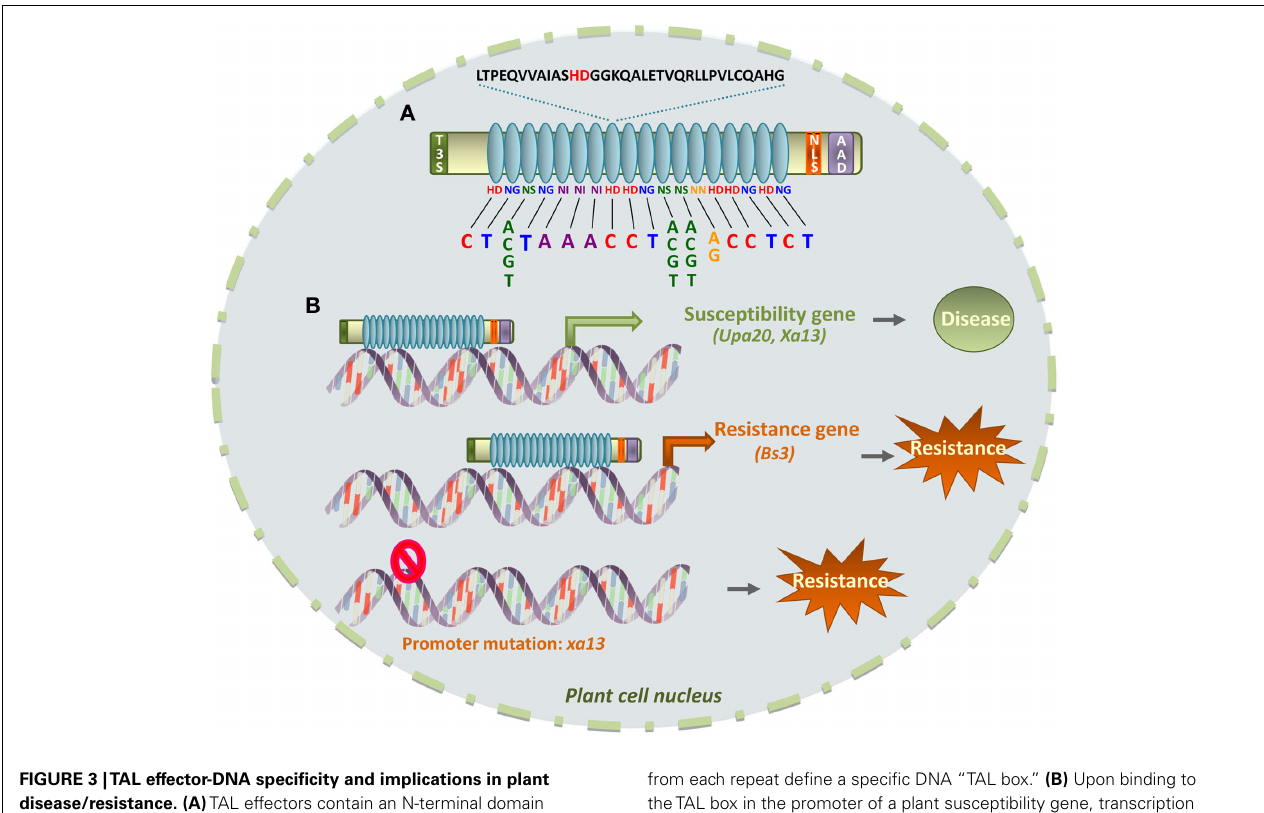
FIGURE 3 |TAL effector-DNA specificity and implications in plant disease/resistance. (A) TAL effectors contain an N-terminal domain required forT3SS-dependent secretion (T3S), a tandem repeat domain (in blue), nuclear localization signals (NLS) and an acidic activation domain (AAD).The central repeat domain confers DNA-binding specificity. One 34-amino acid repeat is shown with the variable di-residue (in red) at positions 12 and 13.The type of di-residue confers specificity for one or several DNA bases, as indicated, and di-residues